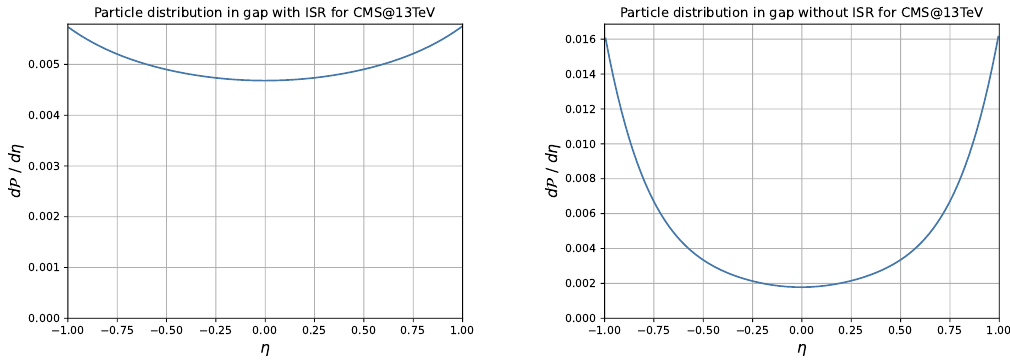
Figure 7 . Distribution of charged-particles in | η | < 1 between the CSE jets for ISR = on (left) and ISR = off (right). The jets satisfy the CMS selection requirements at 13 TeV. The ISR = on induces a flatter distribution in η . The particles that fall into the gap region for ISR = off are coming mostly from wide-angle unclustered hadrons from the